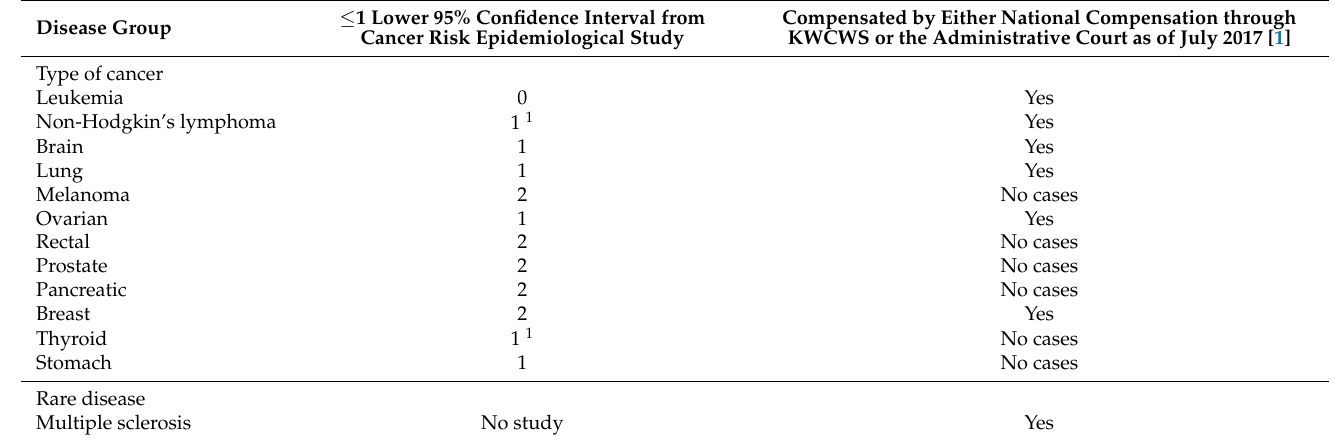
Table 2. Type of cancer and rare disease either examined by epidemiological studies or compensated by KWCWS.